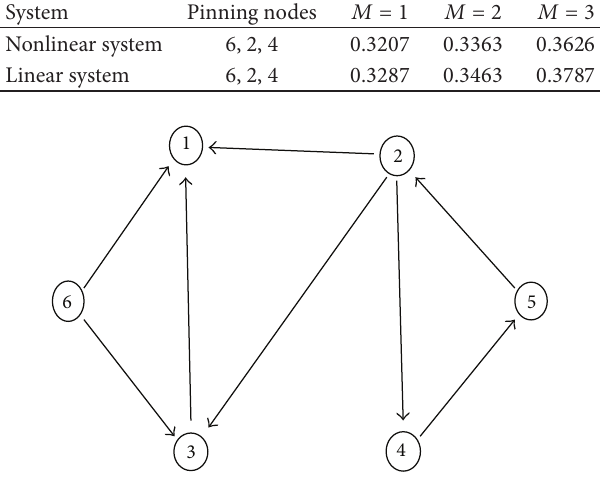
Figure 1: The topology structure of the six agents.